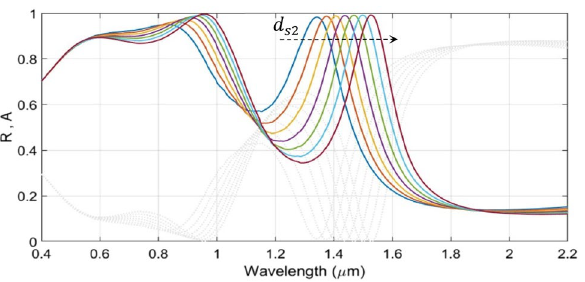
Figure 5. Plots of absorbance A (and reflectance R ) against wavelength under fixed values of d GST1 (= 130 nm) and d GST2 (= 70 nm), and varying values of d s2 ; the other parameters are as used Fig. 1. Coloured lines correspond to absorbance; gray dotted lines represent reflectance. The dashed arrow represents increase in d s2 .